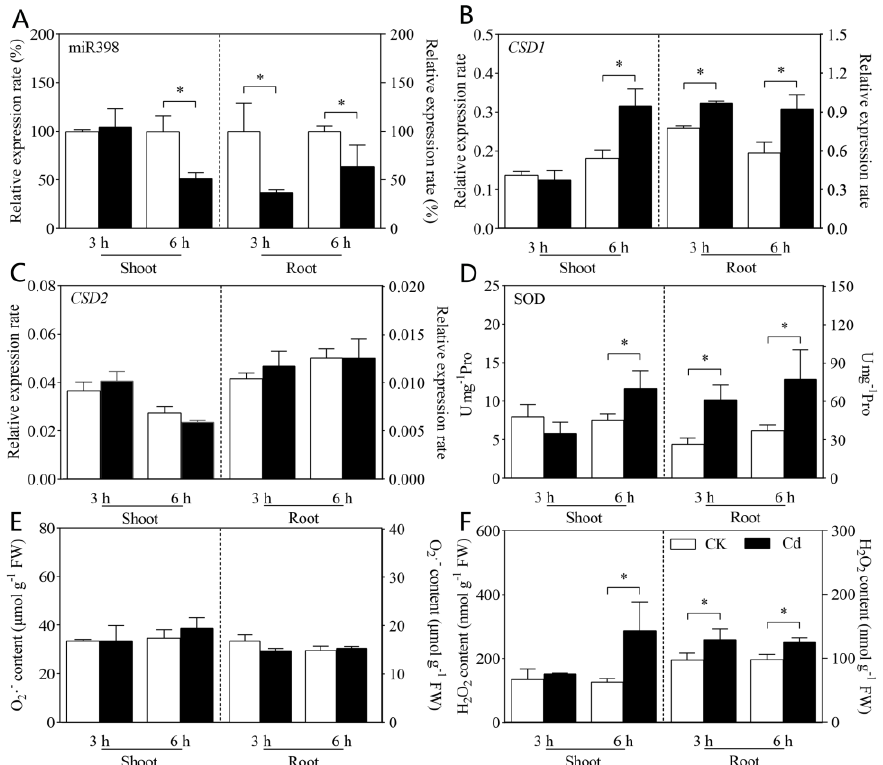
Figure 1. Effects of cadmium stress on miR398 ( A ), CSD1 ( B ), CSD2 ( C ), SOD ( D ), O 2 − ( E ), and H 2 O 2 ( F ) in tomato shoot and root. Tomato seedlings (25 days old, cv. Microtom) were treated with control (CK) and 100 μM Cd(NO 3 ) 2 (Cd) for 3 or 6 h. The data are the mean values + SD of four individual replicates and asterisks indicate significant differences between CK and Cd treatment ( p < 0.05). One unit (U) of activity of SOD is defined as 50% inhibition of the photochemical reduction of nitroblue tetrazolium. SOD, superoxide dismutase, Pro, protein.